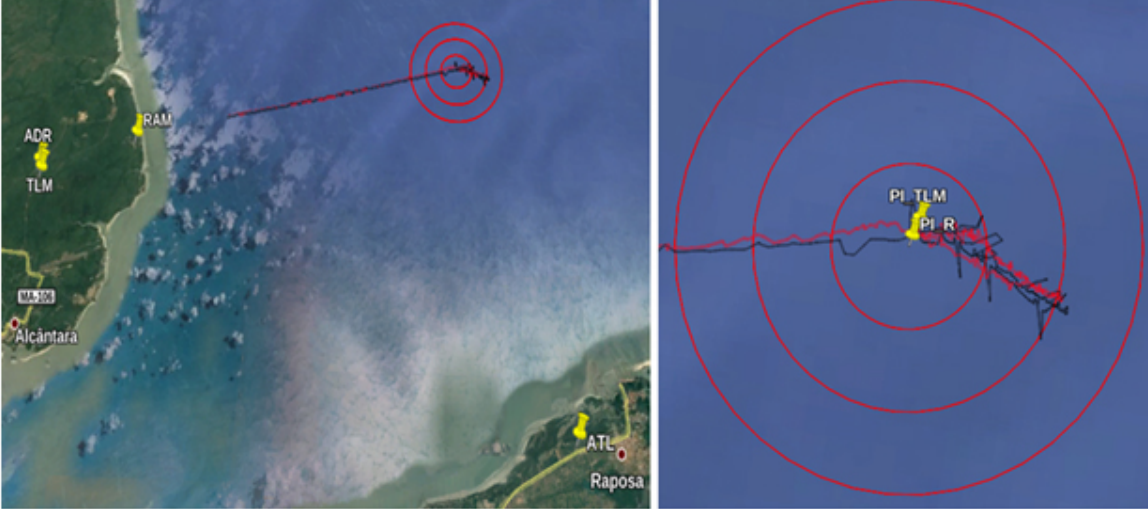
Figure 8. The results obtained from the composition (azimuth, elevation and distance).